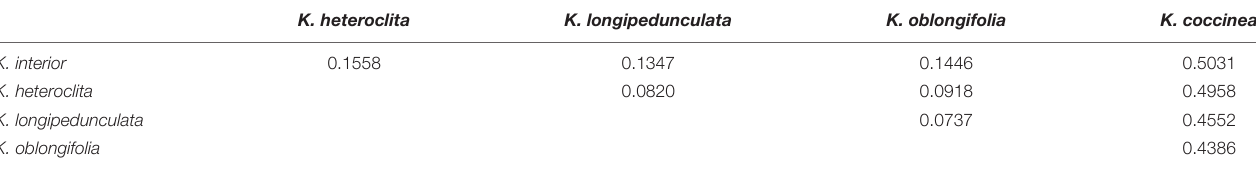
TABLE 3 | Pairwise F ST among K. interior , K. heteroclita, K. longipedunculata, K. oblongifolia , and